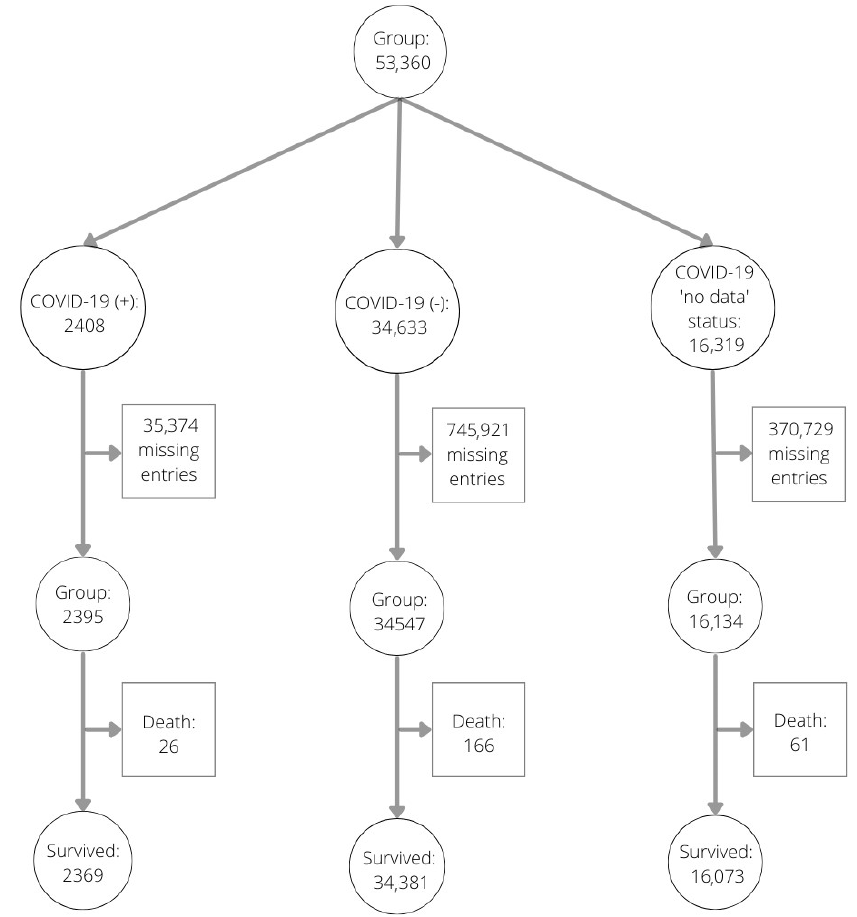
Figure 1. Study Figure 1. Study flowchart.